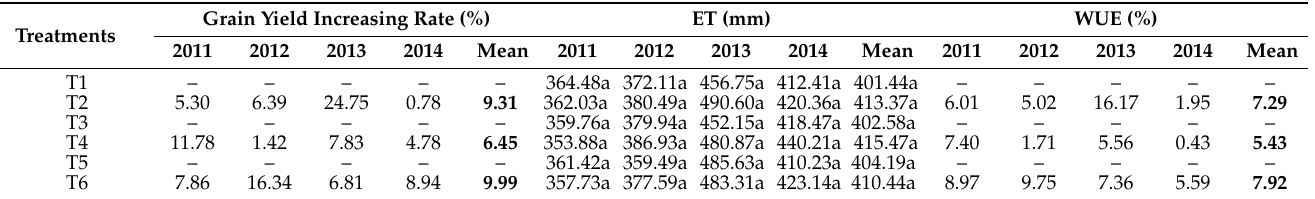
Table 4. Grain yield increase rate, ET and WUE affected by organic manure and three densities.